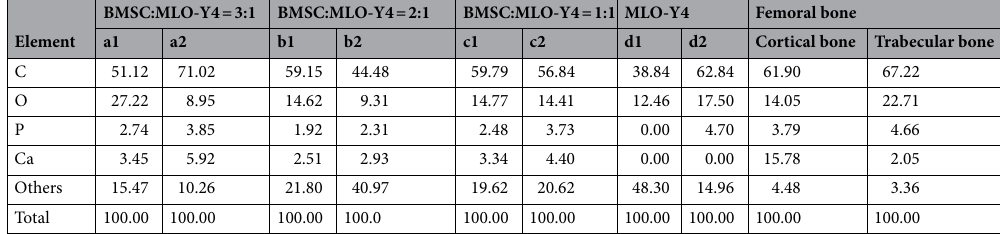
Table 1. The elemental concentrations of bone-like tissues and mouse femoral bone expressed in mass%. C carbon, O oxygen, P phosphorus, Ca calcium, a1, b1, c1, and d1 cortical-like structure, a2, b2, c2, and d2 trabecular-like